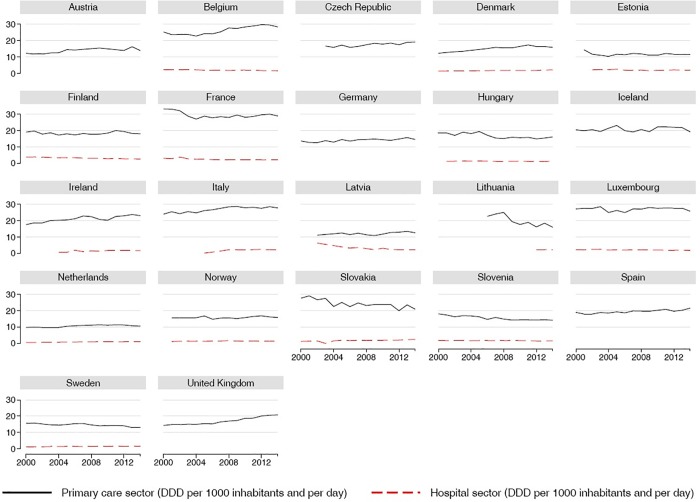
Antibiotics use pattern.